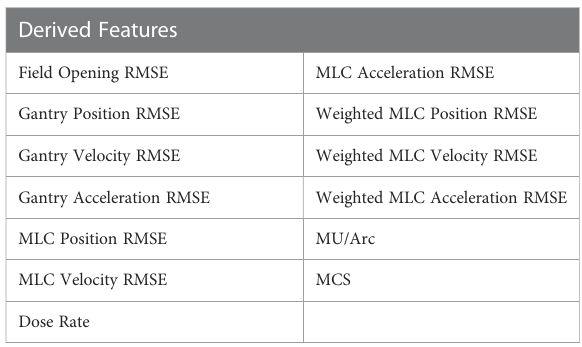
TABLE 1 Table of handcrafted features from log fi le. Derived